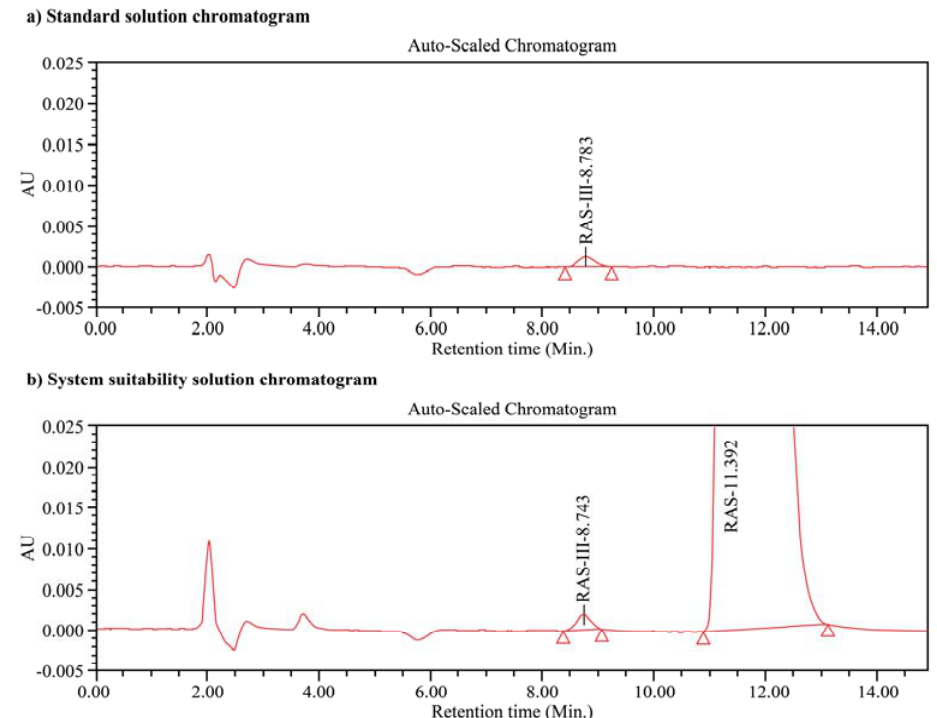
Figure 2. Chromatograms of ( a ) the standard and ( b ) the system suitability (RAS ‐ III = S ‐ enantiomer, RAS = R ‐ enantiomer) solutions. Chromatographic conditions: Chiralpak ® AGP column (50 mm × 2.1 mm, 5 μ m); 90:10 ( v/v ) mixture of ammonium acetate and isopropyl alcohol as the mobile phase; 0.6 mL/min flow rate; 210 nm detection wavelength; and 2.0 μ L injection volume.